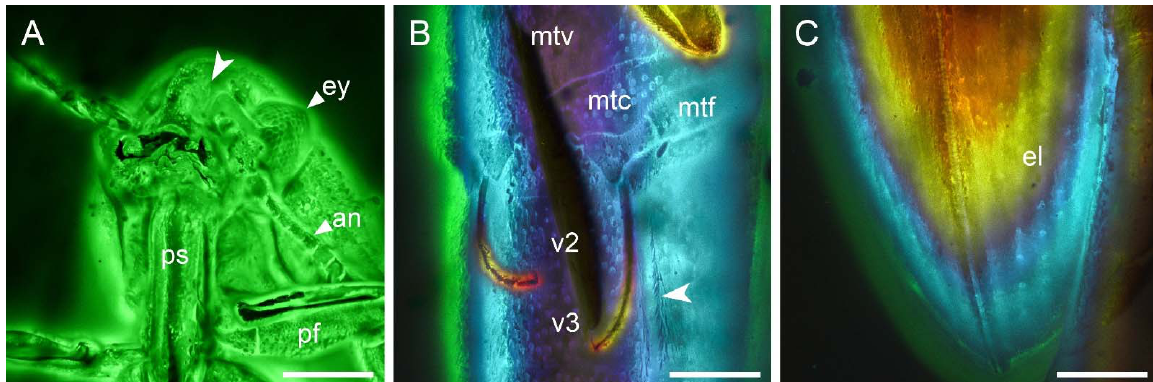
Figure 3. Details of Captopus depressiceps gen. et sp. nov. , holotype, NIGP173915, under confocal microscopy, with depth colour coding in ( B , C ). ( A ) Head and prothorax, ventral view, showing the deep cavity on frons (arrowhead). ( B ) Hind legs and abdomen, ventral view, showing the metatarsal groove (arrowhead). ( C ) Apex of elytra, dorsal view. Abbreviations: an, antenna; el, elytron; ey, compound eye; mtc, metacoxa; mtf, metafemur; mtv, metaventrite; pf, profemur; ps, prosternum; v2–3, ventrites 2–3. Scale bars: 200 µ